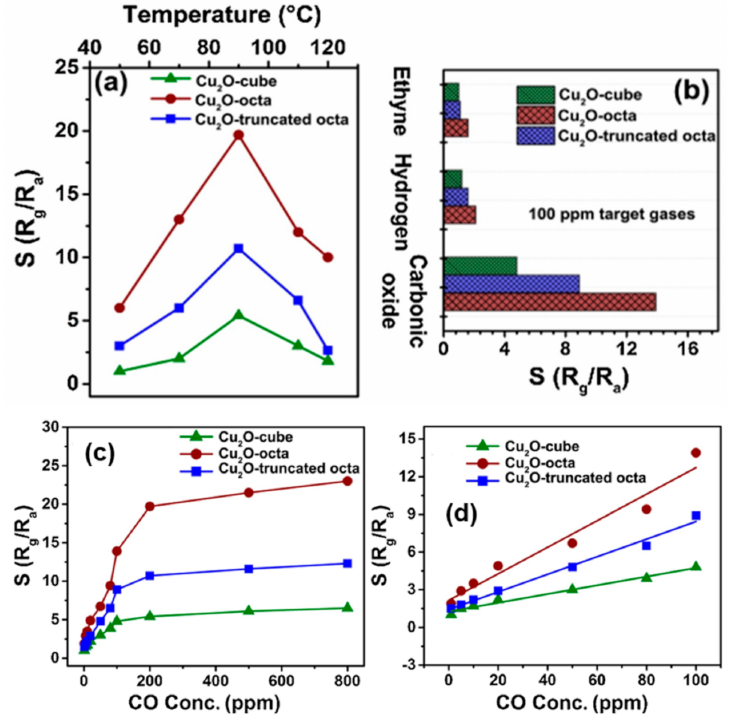
Figure 10. ( a ) The relationship of working temperature and CO-sensing response of three Cu 2 O particle-based sensors to 200 ppm CO; ( b ) Sensor responses of Cu 2 O sensors to 100 ppm of CO, H 2 , and C 2 H 2 at 90 ◦ C; ( c ) Response versus CO concentration of Cu 2 O sensors at 90 ◦ C; ( d ) The corresponding sensor response curves to CO concentration from 1 to 100 ppm; The straight line show fits the data. Reprinted from Ref. [140] with the permission of Elsevier Ltd.,